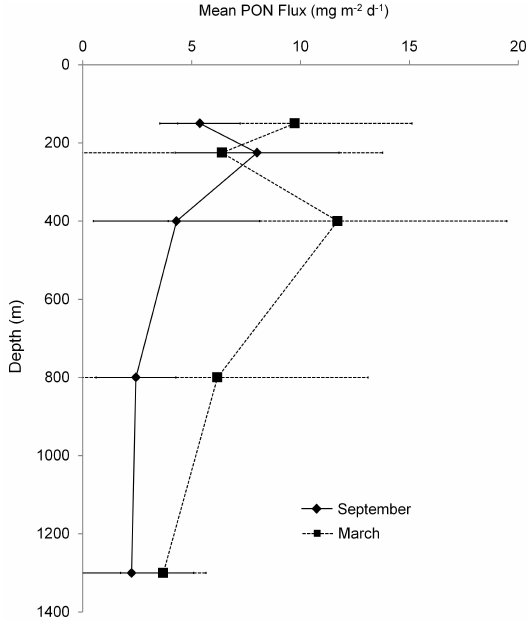
Fig. 7. Mean vertical PON flux during September (non-upwelling) and March (upwelling) months from the CARIACO Ocean Time Series between 1997 and